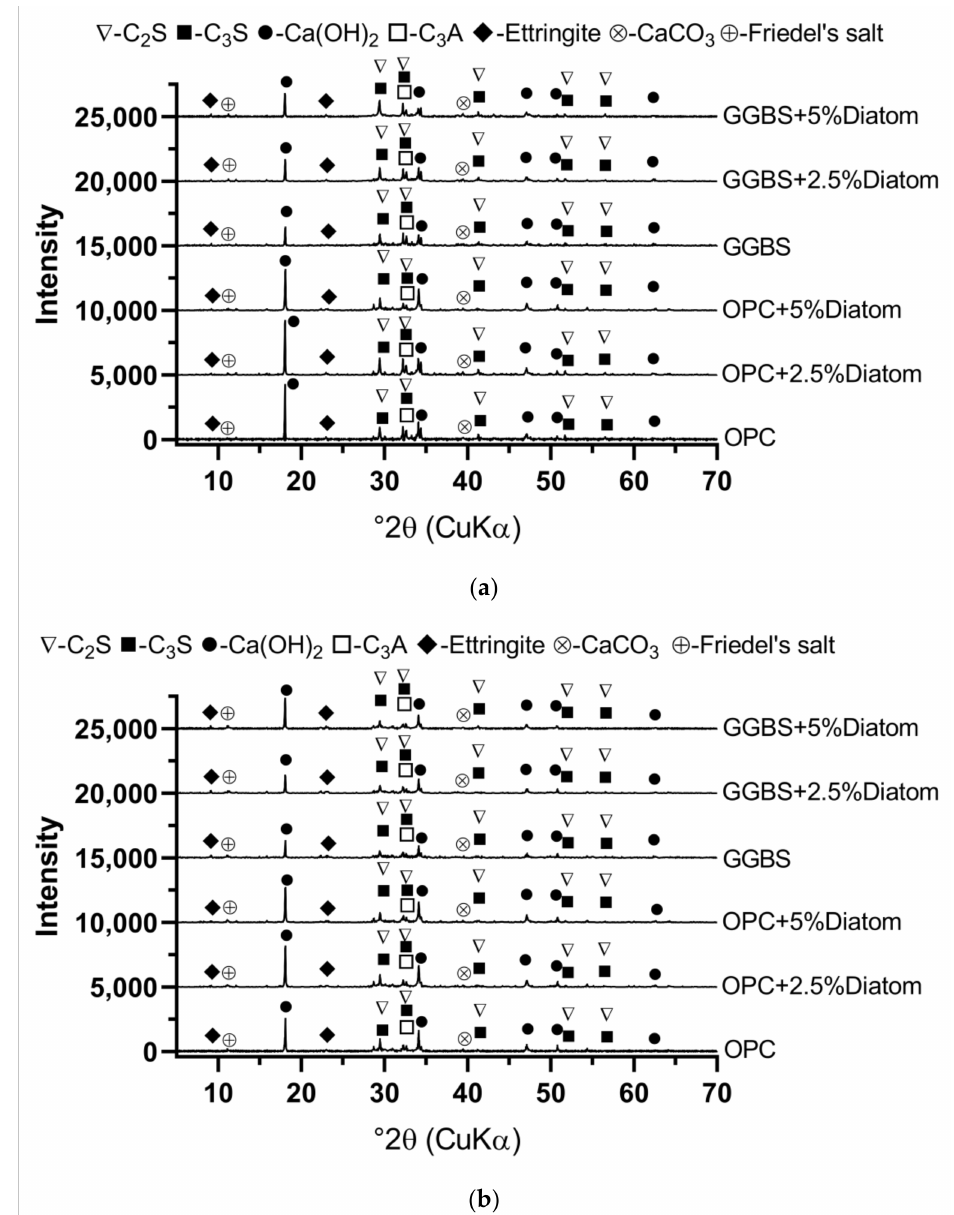
Figure 3. XRD results of different mixes: ( a ) 1 day, ( b ) 28